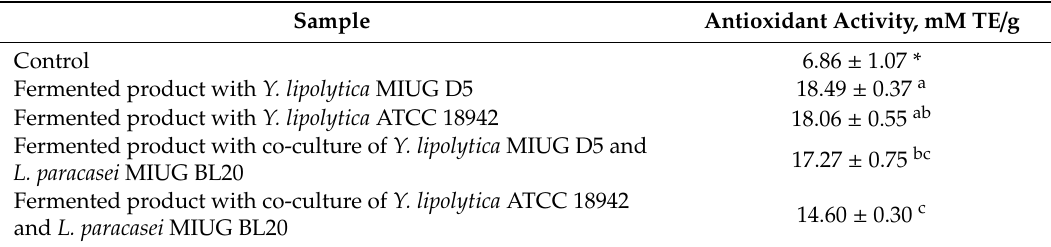
Table 3. Antioxidant activity of the fermented products.